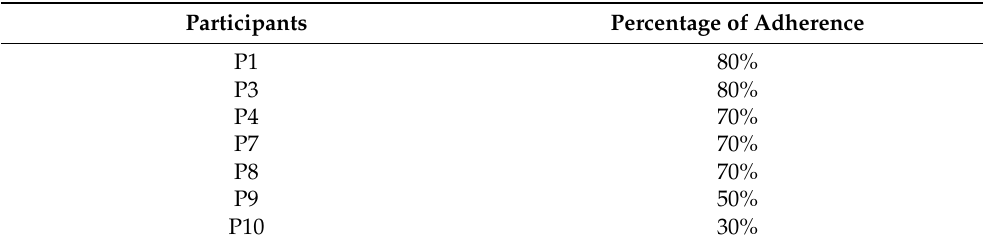
Table 4. Adherence to the programme in terms of percentage of practice regarding the recommended daily